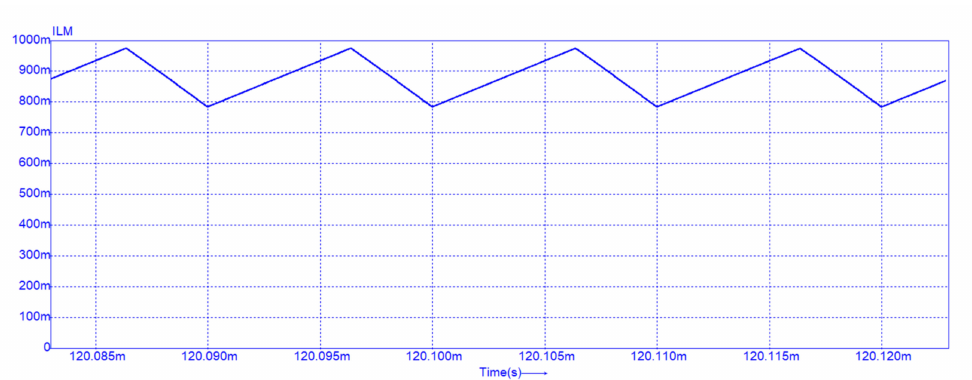
Figure 8. Output dc voltage.